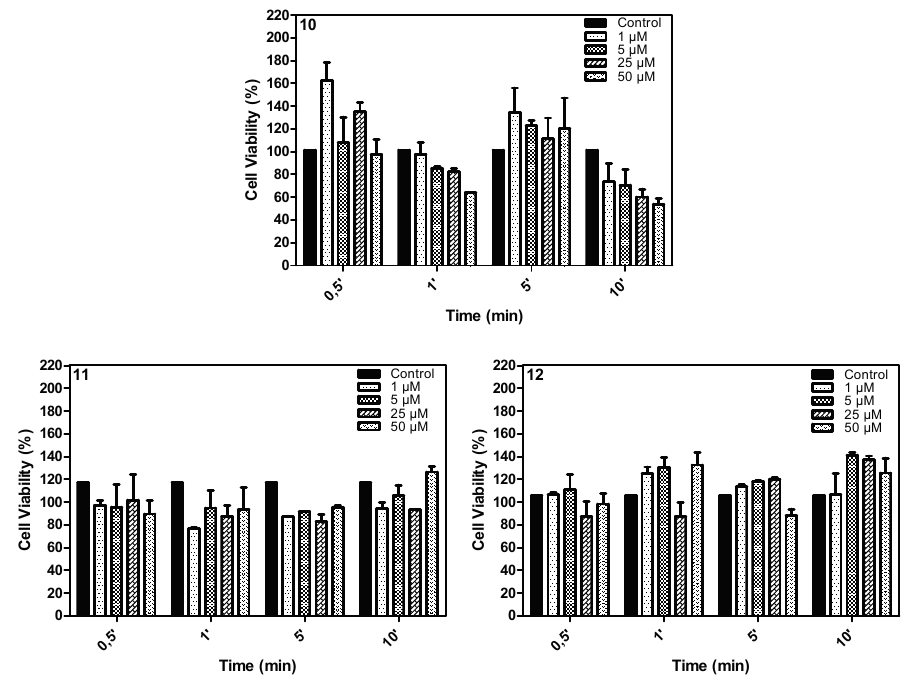
Figure 9. Phototoxic effect of compounds 10 , 11 and 12 on the MCF-7 cell line in different irradiation times (50 μ M, 25 μ M, 5 μ M and 1 μ M; 2 h incubation). The control group did not receive the light treatment, only the